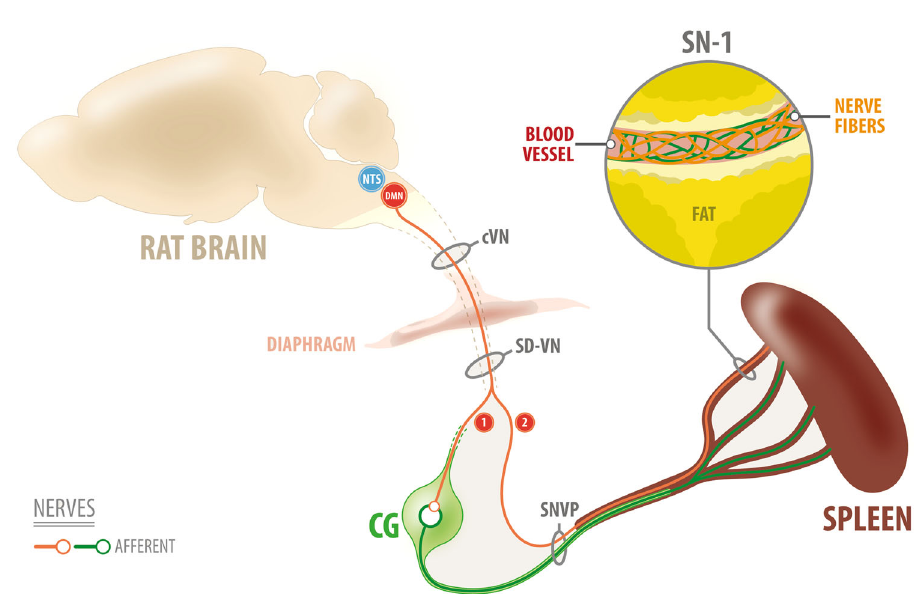
Fig. 9 Brain-splenic control. Schematic of proposed innervation of the spleen. (1) Neurons from the dorsal motor nucleus of the vagus (DMN) synapses in the celiac ganglia (CG) peripherally. The CG contains sympathetic norepinephrine fi bers that innervate the spleen. (2) This work supports the presence of parasympathetic axons in the vagus nerve, that originate from neurons in the DMN and innervate the spleen directly. Projections from the DMN travel in the subdiaphragmatic vagus nerve (SD-VN), ending in terminal branches of the spleen (i.e., SN-1). SNVP splenic neurovascular plexus, cVN cervical vagus